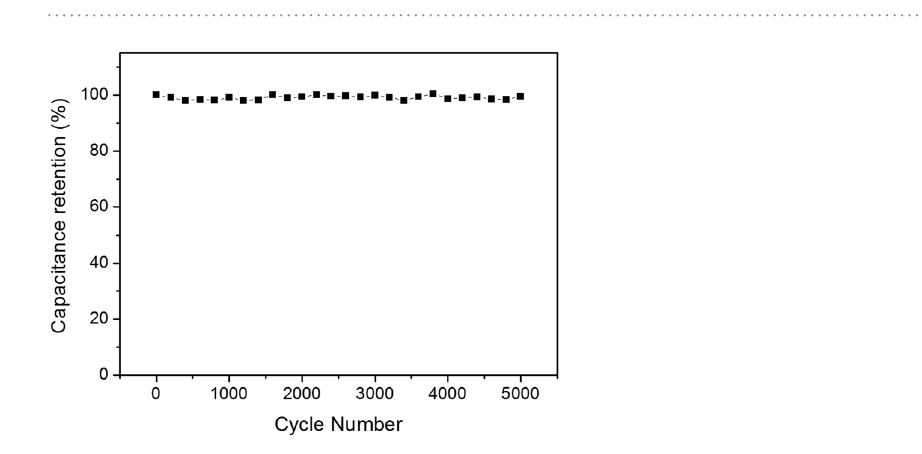
Figure 8. Nyquist plots of BF-850, BFH-750, BFH-850, and BFH-950 based electrode materials under the influence of an AC voltage of 5 mV.